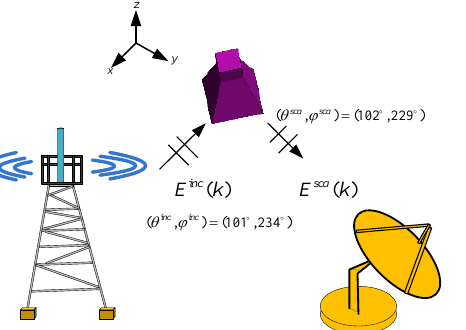
Figure 5. The posture of the coated target based on Sub6 base station illuminator.